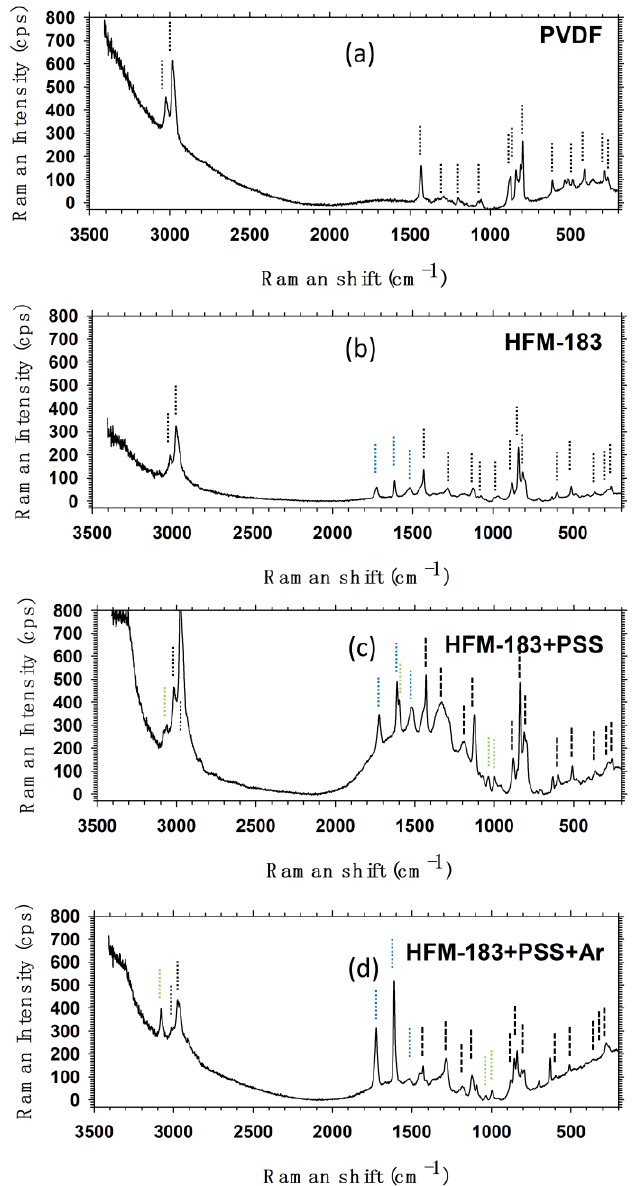
Figure 13. Raman shift for pure PVDF and the membranes studied. ( a ) PVDF pure film, ( b ) HFM-183 pristine membrane, ( c ) HFM-183+PSS membrane, and ( d ) HFM-183+PSS+Ar membrane.